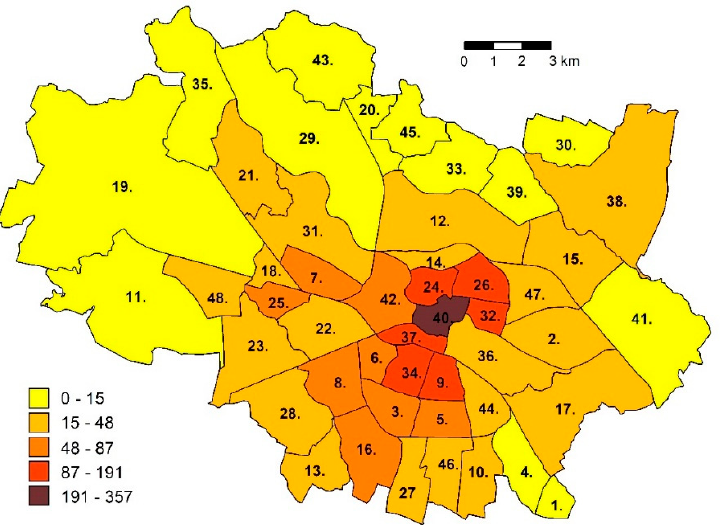
Figure 2. Density of industrial entities (number per km 2 ) in Wrocław in the layout of housing estates in 2016 (sourced by authors). Names of settlement units: 1. Bie´nkowice 2. Biskupin, S˛epolno, D ˛abie, Bartoszowice 3. Borek 4. Brochów 5. Gaj 6. Gajowice 7. G ą dów, Popowice P ł d. 8. Grabiszyn, Grabiszynek 9. Huby 10. Jagodno 11. Jerzmanowo, Jarno ł tów, Strachowice, Osiniec 12. Kar ł owice,